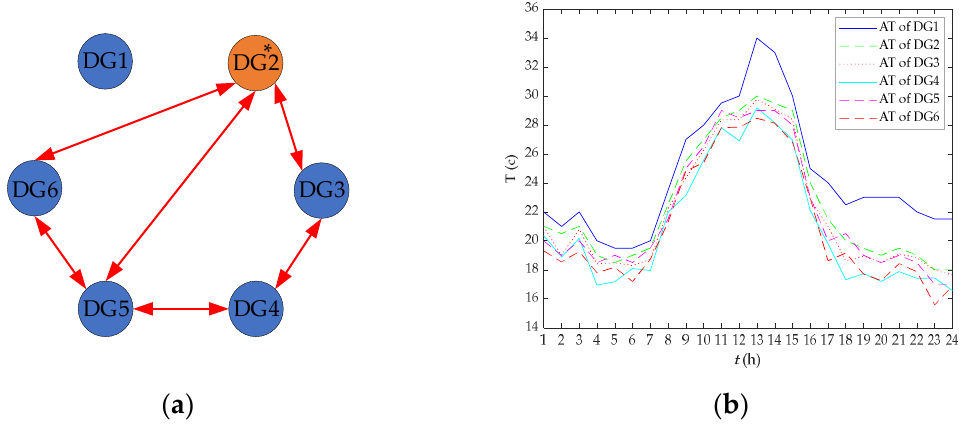
Figure 29. Communication topology of the system under DLR constraint and changes curves of AT of each DG: ( a ) communication topology of the system under DLR constraint; ( b ) change curves of AT of each DG.